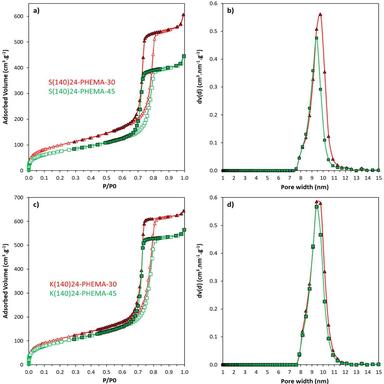
N2 at 196 C physisorption isotherms and corresponding NLDFT desorption pore size distributions of S(140)24-PHEMA (a,b) and K(140)24-PHEMA (c,d) composite materials.